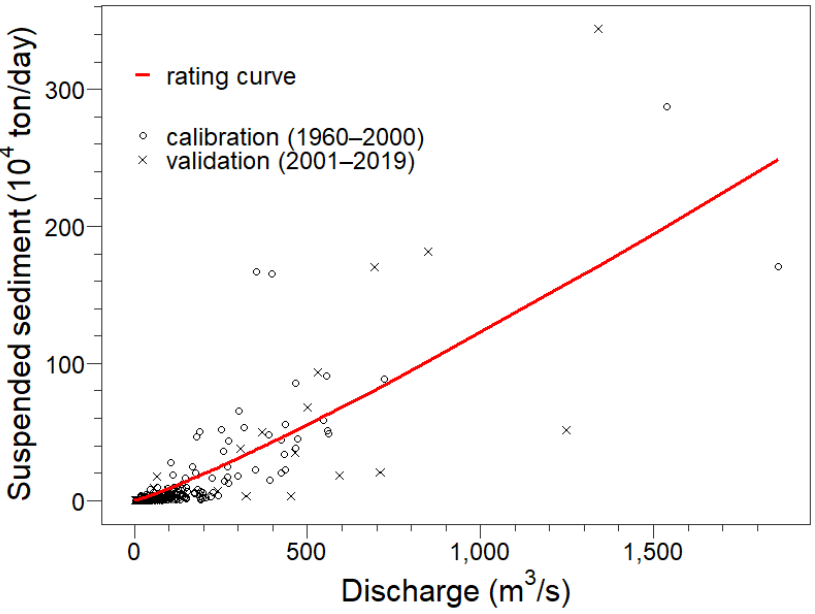
Figure 1. Scatter diagram of recorded daily suspended sediment load and streamflow discharge and the corresponding sediment rating curve at Jenshou station.